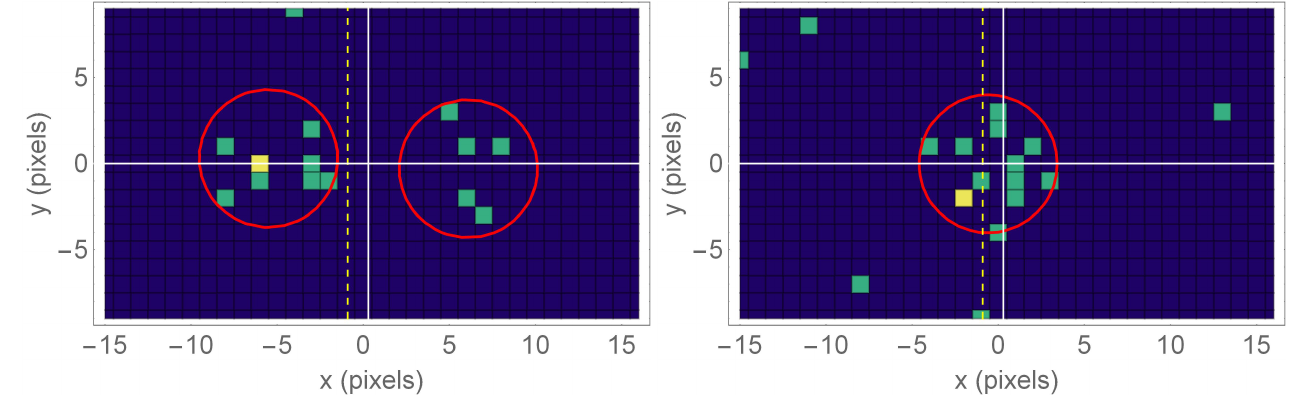
( a ) Projective measurement case (14 detection events). ( b ) Protective measurement (17 detection events). Figure 5. Few-event photon counts distributions for the input state marked in yellow. While PJ ( a ) requires a measurement on an ensemble of identically prepared particles, PM ( b ) allows extracting the expectation value of our observable with just a single click. Yellow dashed line: x position corresponding to the theoretical expectation value of the polarization (cid:104) A (cid:105) th = − 0.208; red circles: FWHM of the corresponding distributions (cid:12) (cid:69) 17 (cid:12) π for the state reported in Figure (cid:12) 60